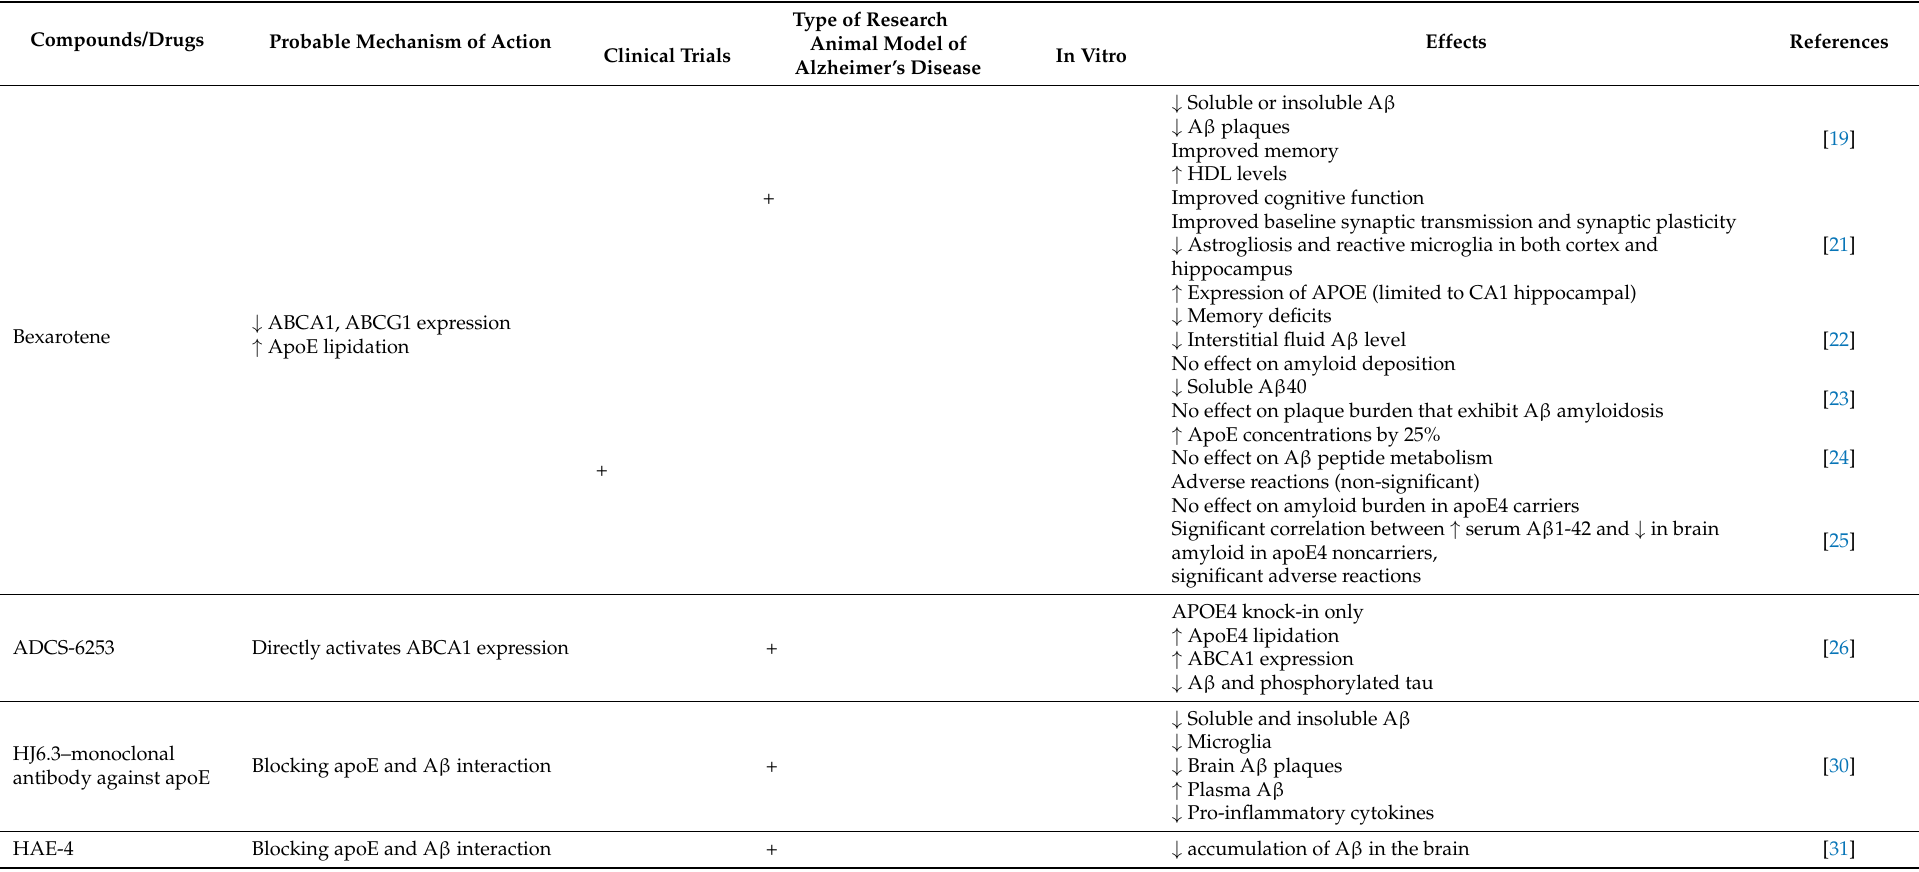
Table 2. Selected drugs and compounds as candidates for the management of Alzheimer’s